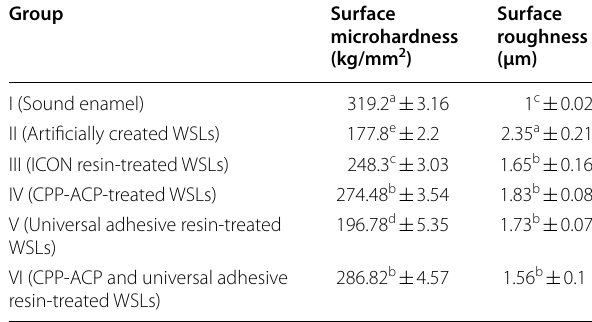
Means with the same superscript letter in each column are not significantly different at